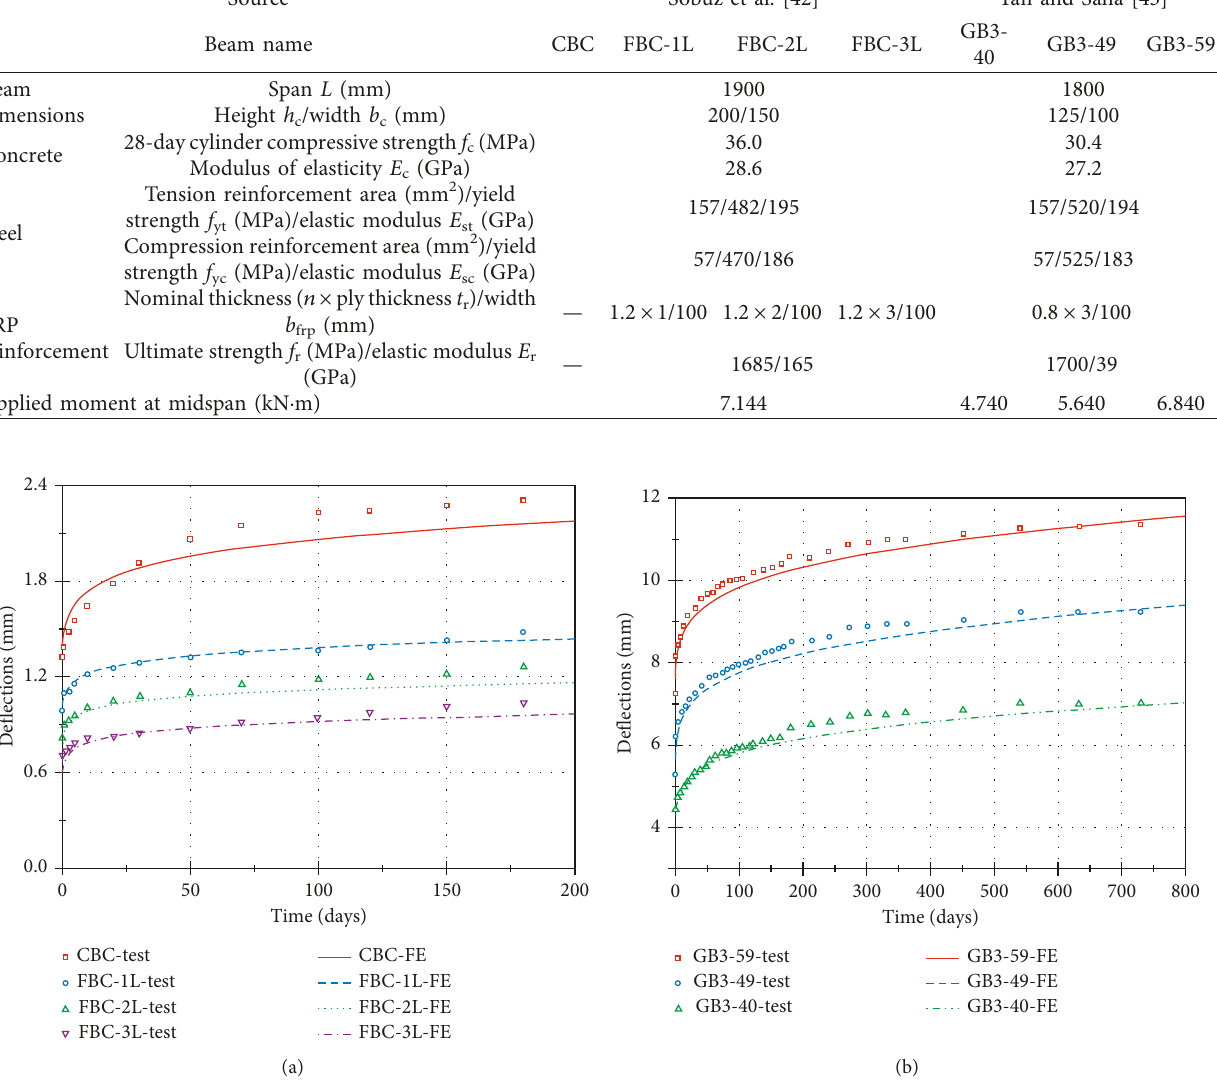
Figure 9: FE versus test deflections at midspan. (a) FE and test results for Sobuz’s [42] specimens. (b) FE and test results for Tan’s [43]